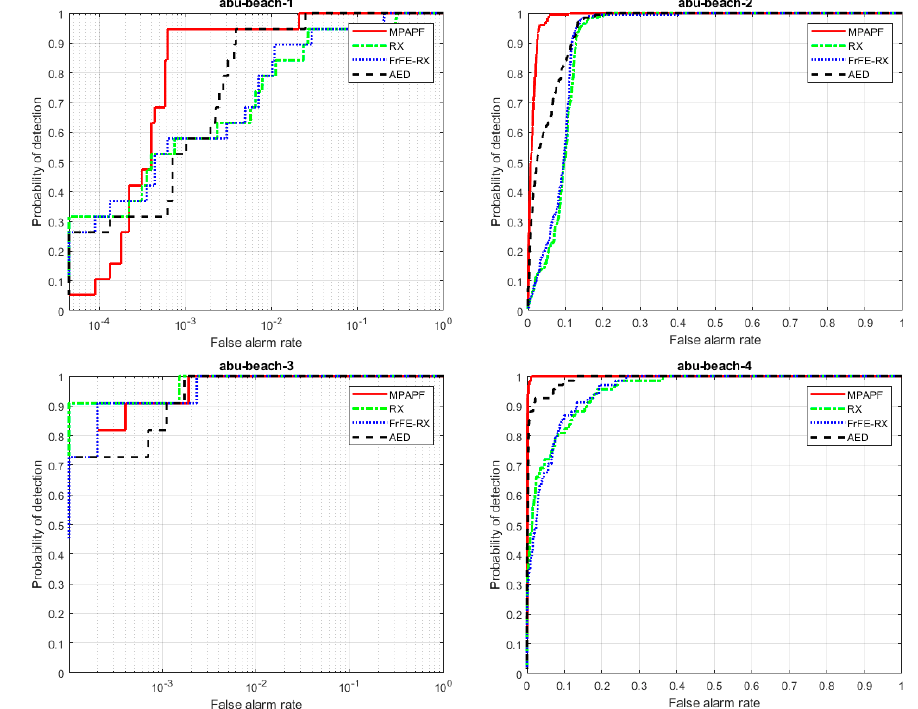
Figure 8. ROC curves of the compared methods on the ABU-Beach Scene.